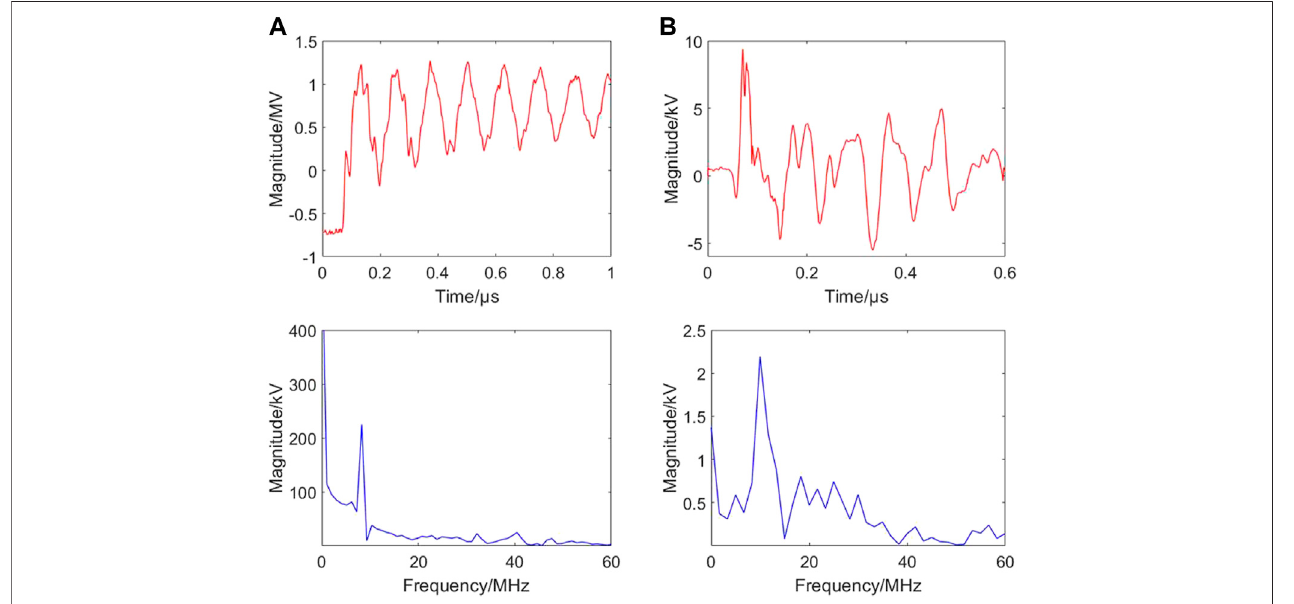
FIGURE 7 | Typical measured disturbance source waveform. (A) VFTO. (B) TEV.